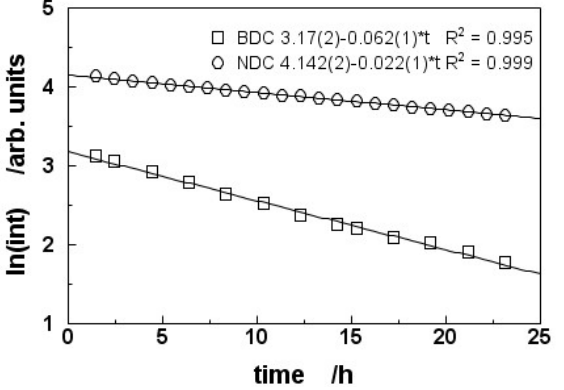
Figure 5. Kinetics of the loading of ferrocene inside Cu(bdc)(dabco) Cu(ndc)(dabco) ( 2 ) ( ○ ). The data are plotted as the natural log of intensity against time to 1/2 obtain diffusion